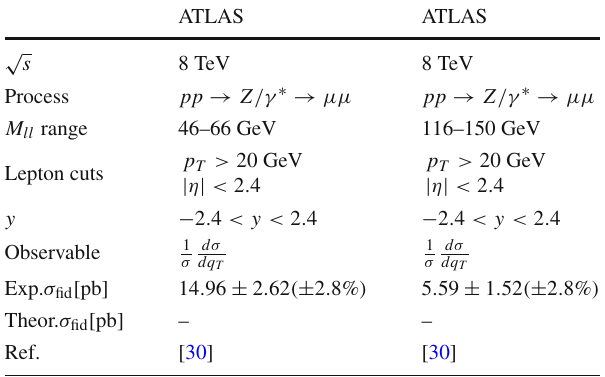
Table 6 The characteristics of the data for the vector boson production off the Z-peak measured by ATLAS collaborations ATLAS